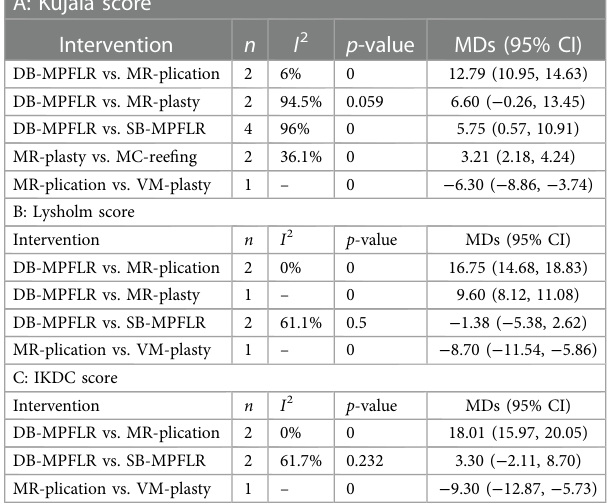
TABLE 2 Results from pair-wise meta-analysis. A: Kujala